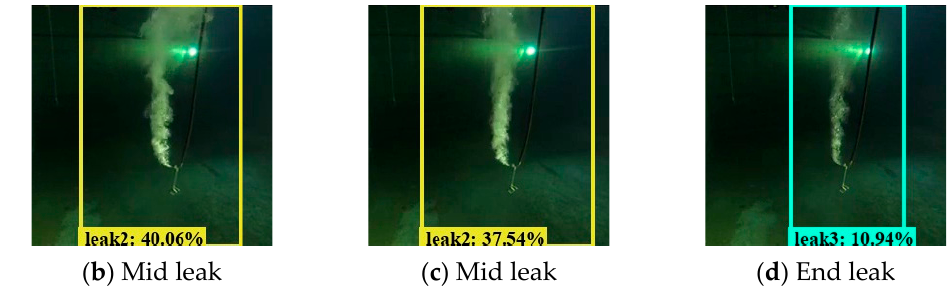
Figure 20. Visualization examples of the YOLOv4 model developed by the image size 480 × 480 dataset under the Co. L. Mar. dataset.